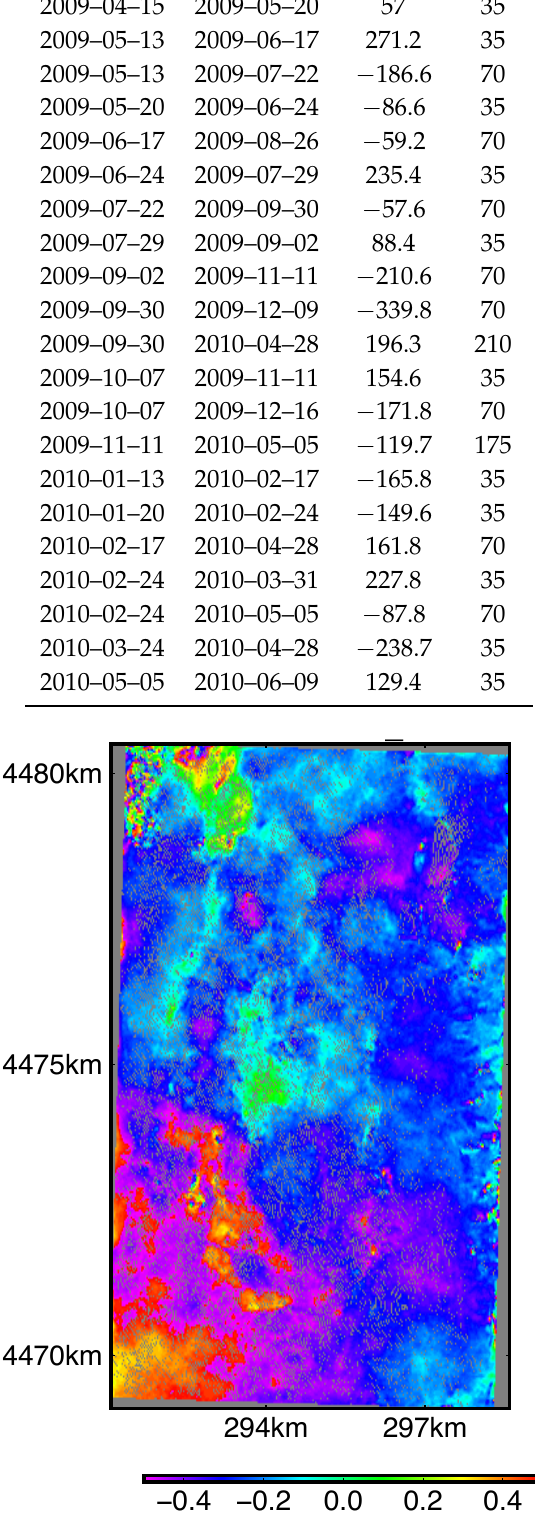
Figure A1. Deformation field at San Emidio in terms of wrapped range change in cycles from an ERS track 27 pair spanning 20th June 1995 to 29th August 1995. One cycle of wrapped phase corresponds to a range change of approximately 28 mm. Orbital baseline b ⊥ = 223.5 m and temporal baseline ∆ t = 70 days. Coordinates are easting and northing kilometers in UTM projection zone 11N, WGS84